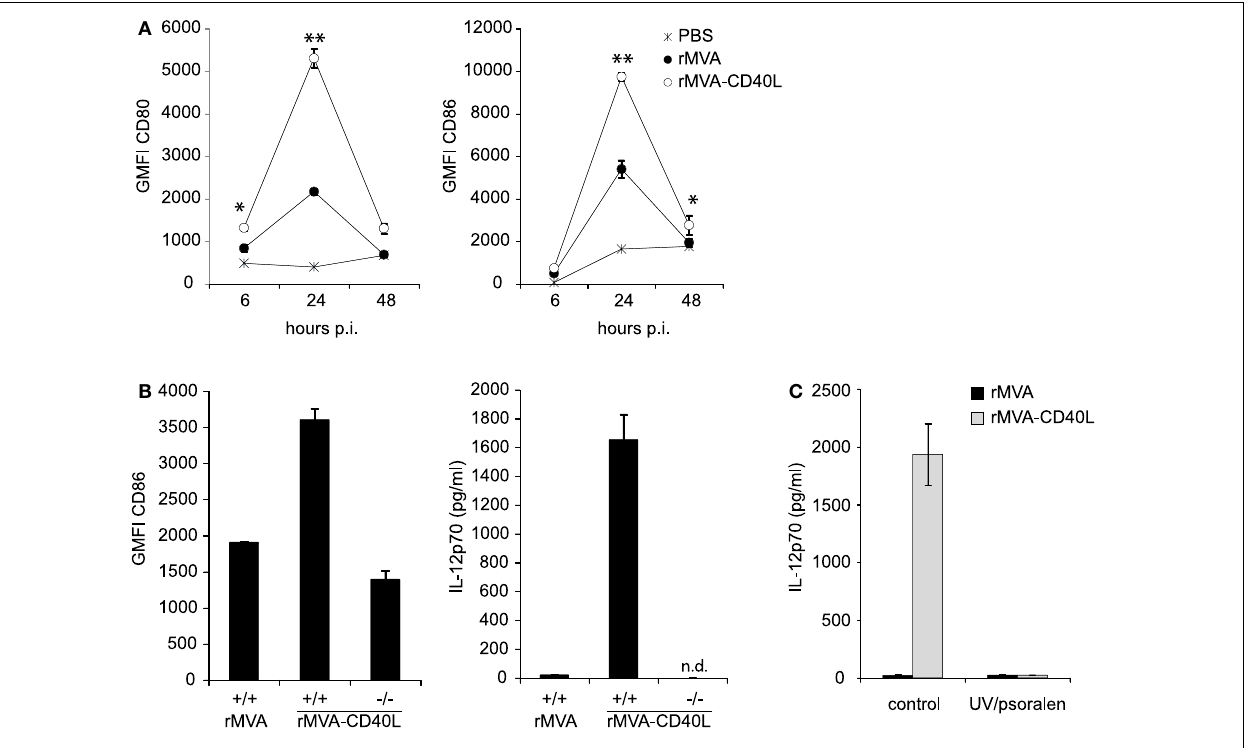
FIGURE 5 | Enhanced DC activation in vivo after rMVA-CD40L immunization . C57BL/6 mice were treated with PBS, rMVA, or rMVA-CD40L. (A) Six, twenty four, and forty eight hours after injection splenic DCs were analyzed for expression of the activation markers CD80 and CD86. Similar to in vitro transduced DCs (see Figure 3 ), splenic DCs were more strongly activated by rMVA-CD40L.The peak of activation was at 24h post immunization. (B) In order to test whether the enhanced immunogenicity of rMVA-CD40L is dependent on the interaction of CD40 and virally encoded